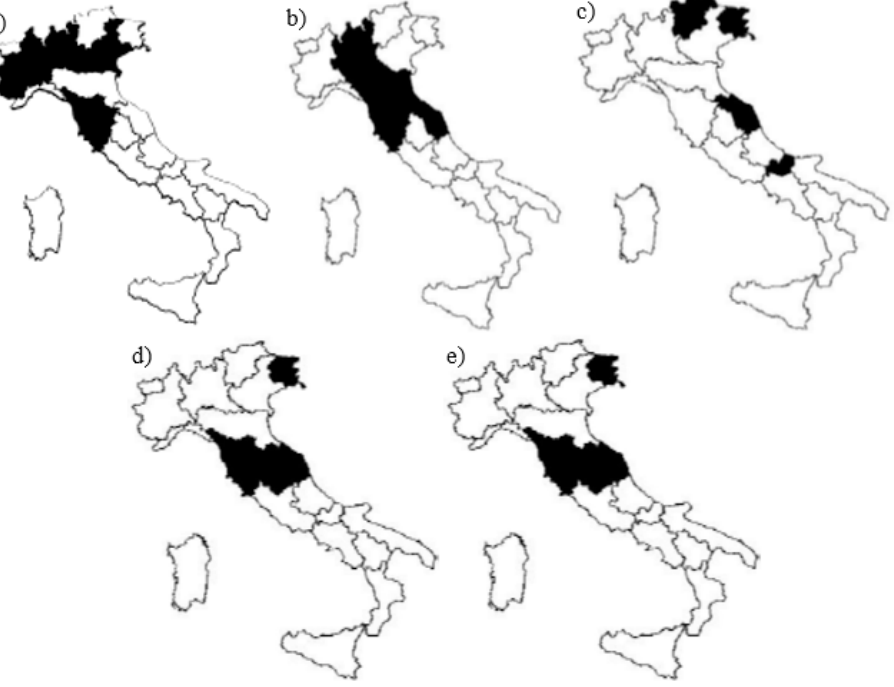
Source: Elaboration on Microbirrifici.org. Data refers to the year